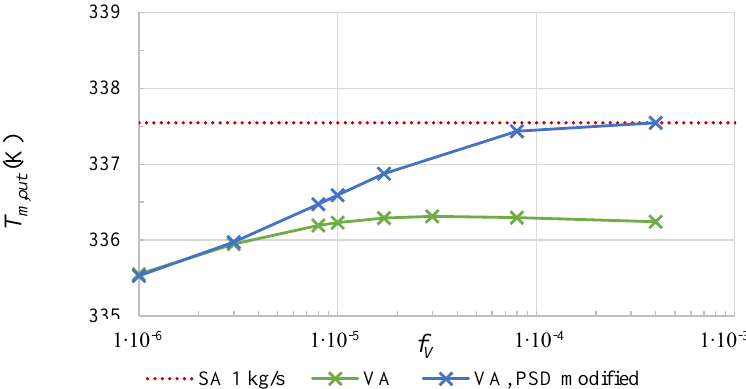
Figure 6. The average fluid temperature T m , out at the outlet as a function of the volume fraction of the VA (solid lines) at a mass flow rate of ˙ m = 1 kg/s. For comparison, the average fluid temperature of the SA is shown as red dotted line.